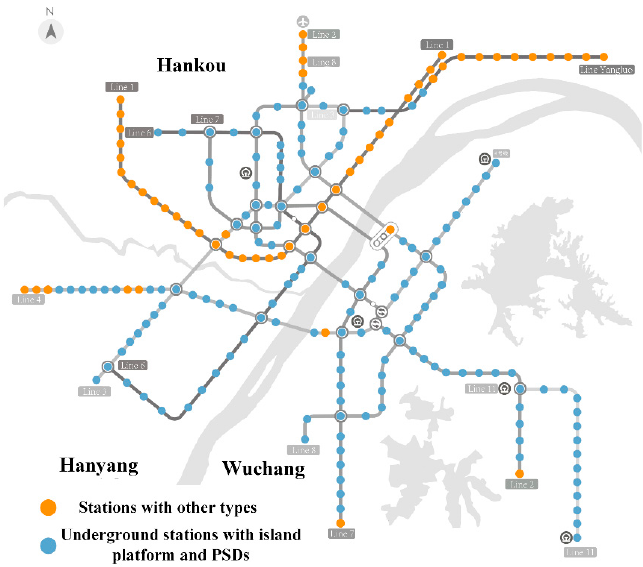
Figure 1. Underground stations with island platforms and PSD systems.